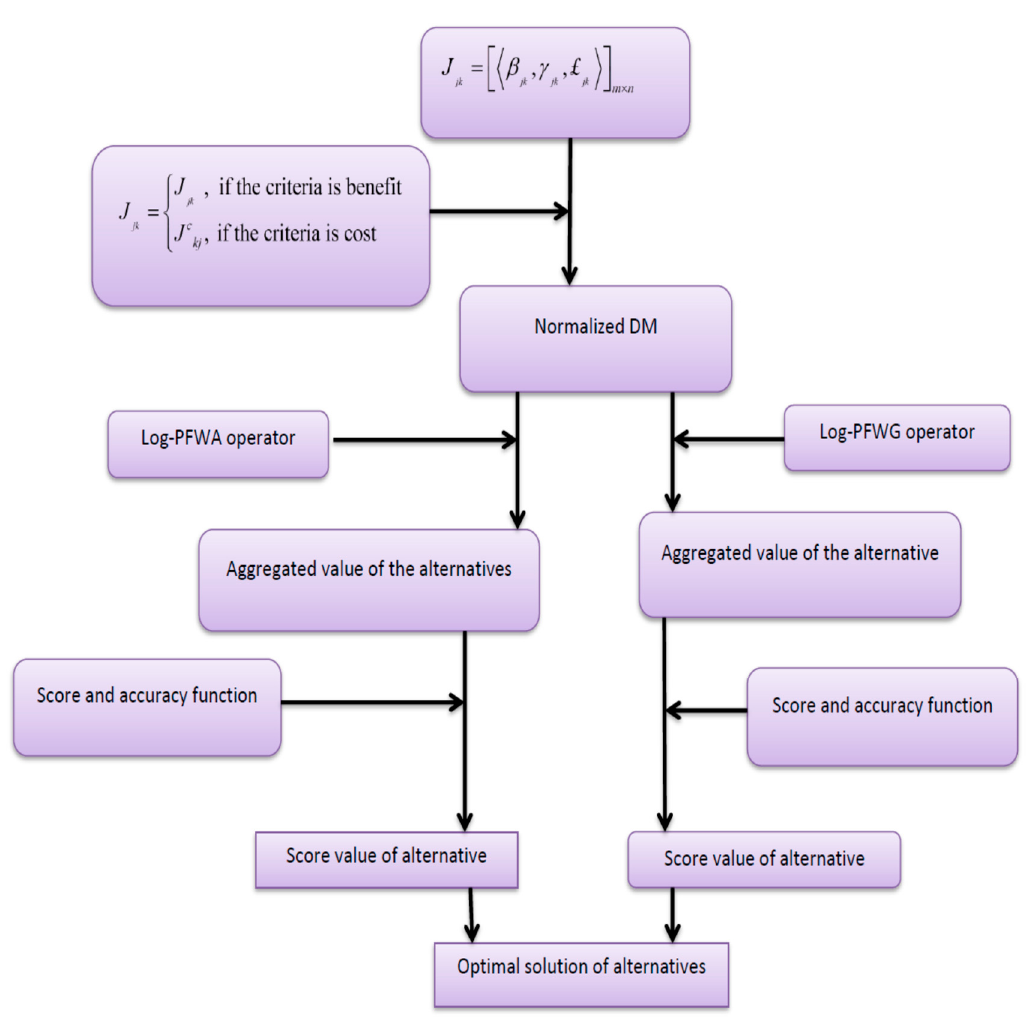
Figure 1. Graphically presentation of the proposed method.